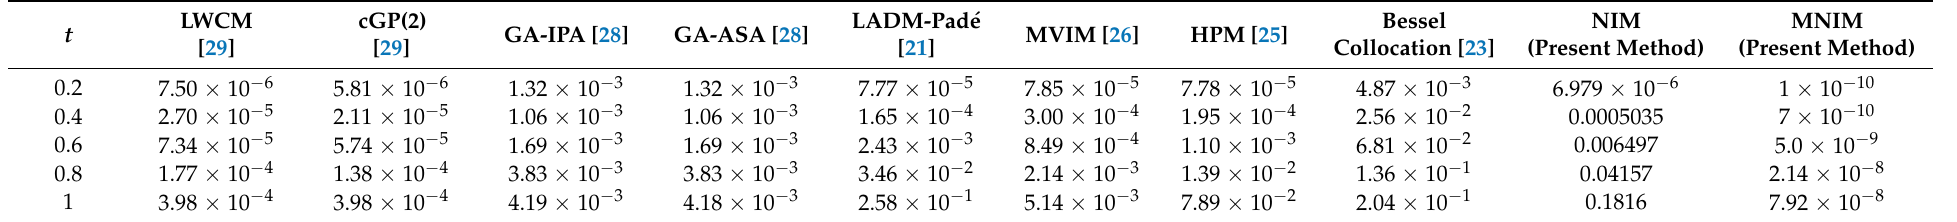
Table 2. Comparison of Absolute Errors for X ( t ) of MNIM Scheme and LWCM, cGP(2), GA-IPA, GA-ASA, LADM-Pad é , MVIM, HPM, Bessel collocation, NIM relative to RK4 Method for HIV Infection Model.